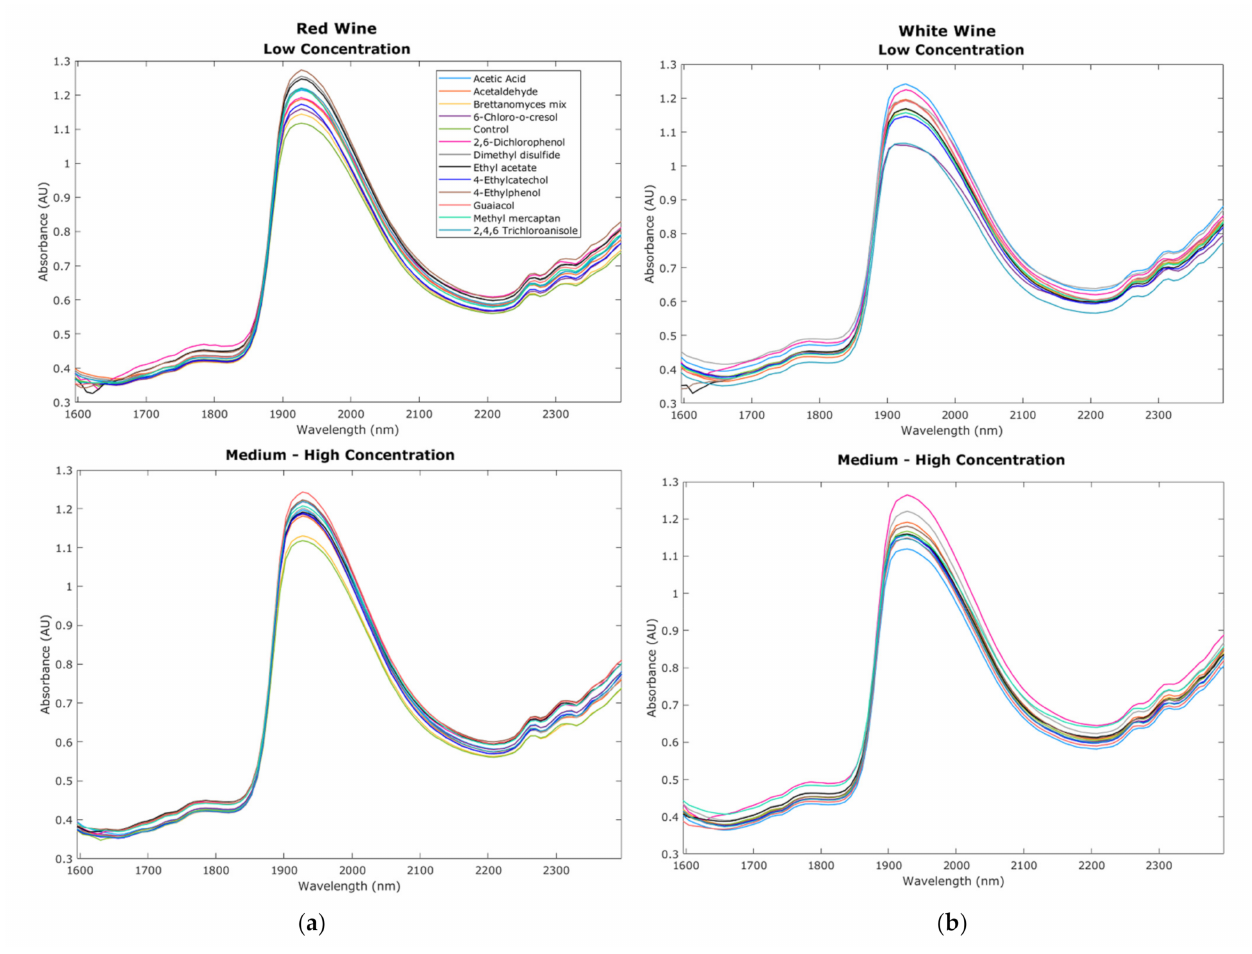
Figure 3. Chemical fingerprinting obtained from the near-infrared spectroscopy measurements within the 1596–2396 nm range. Curves display the results from ( a ) red wine and ( b ) white wine raw absorbance values from low and medium–high concentration